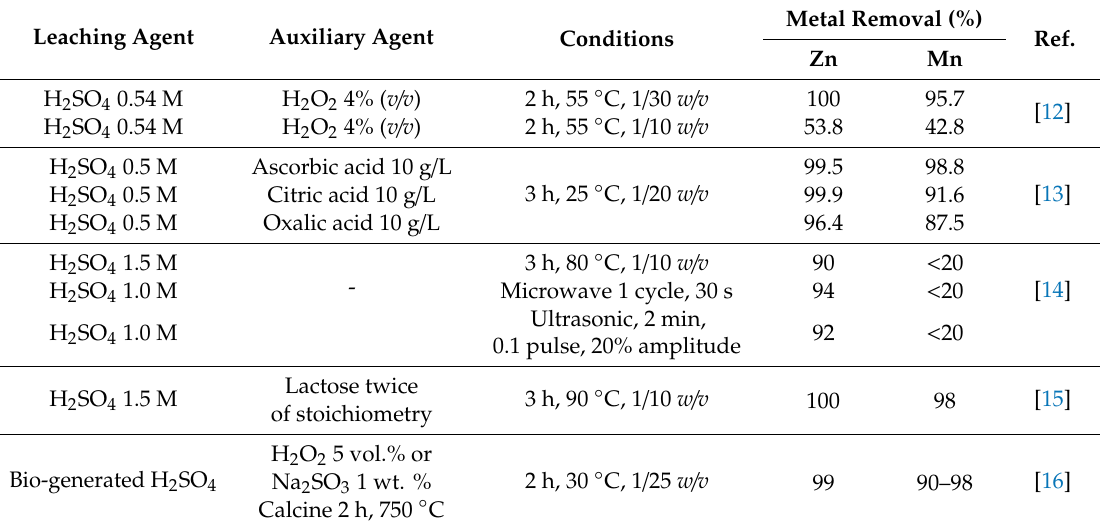
Table 1. Leaching yields of Zn and Mn from alkaline battery by acid